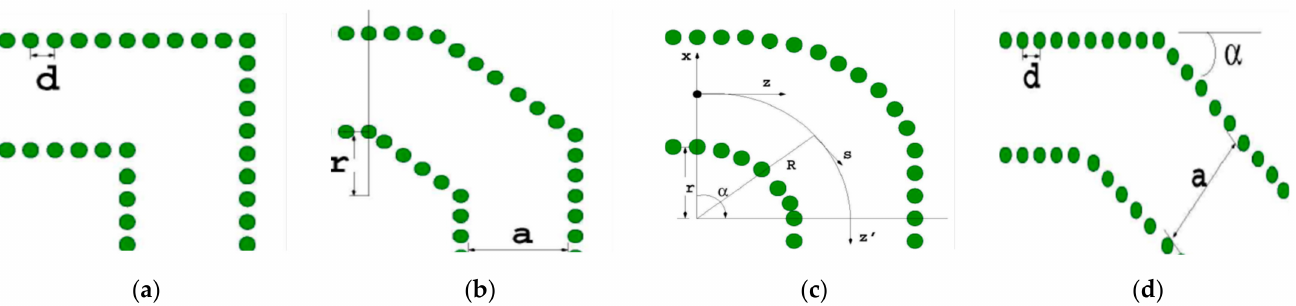
Figure 5. Different curve structures: ( a ) the right-angle curve structure; ( b ) the straight-cut curve structure; ( c ) the smooth curve structure; ( d ) the diagonal curve structure.